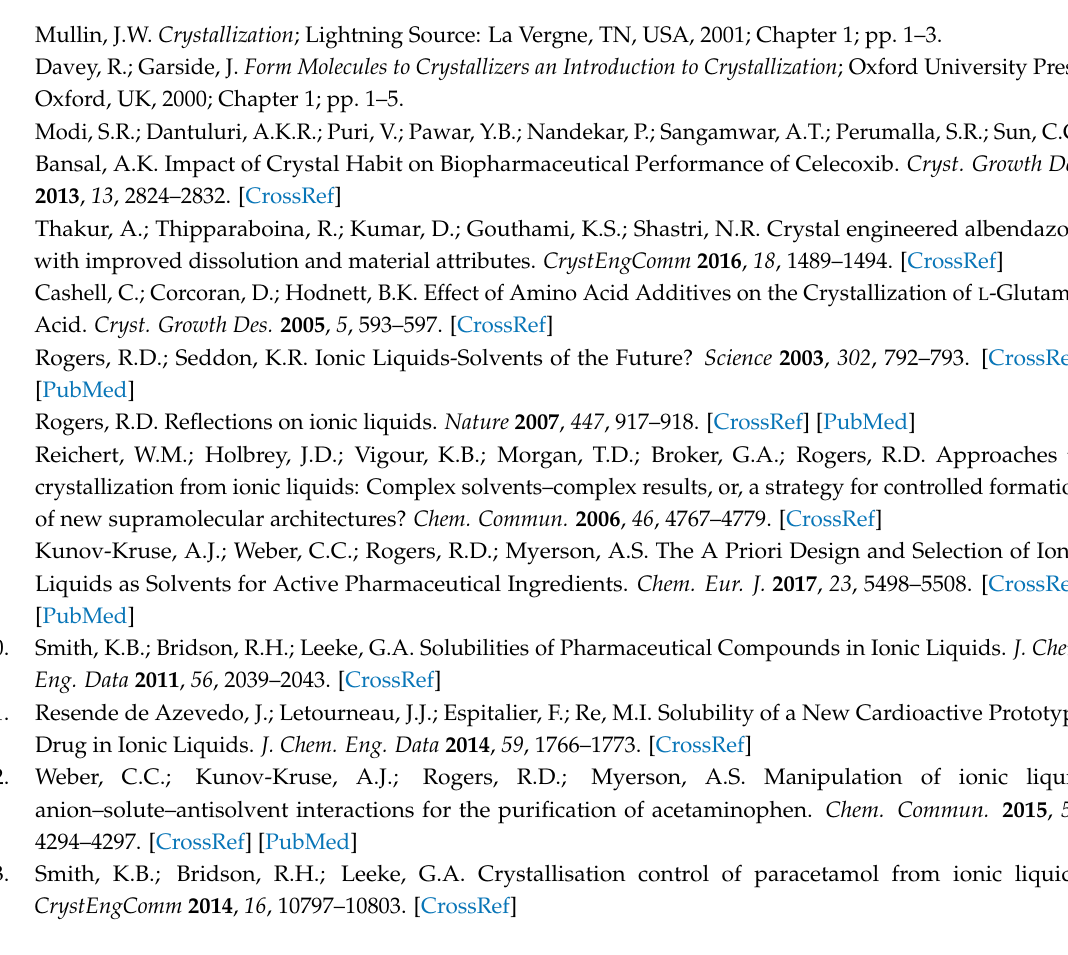
Figure S1. Crystal morphology of the currently commercialized sucrose crystals recorded by using the video microscope; Figure S2. PXRD patterns of sucrose crystals isolated from the MeOH extraction solution of A. gigas under controlled solvent volume (3 mL) and BMImBF 4 anti-solvent concentration change conditions, using crystallization techniques; Figure S3. PXRD patterns of sucrose crystals produced from the MeOH extraction solution of A. gigas at constant solvent volume of 3 mL under BMImPF 6 anti-solvent composition variation conditions using the crystallization method; Figure S4. Video-microscope photographs of sucrose crystals obtained from the MeOH extraction solution of A. gigas (solvent volume of 3 mL) using, respectively, BMImBF 4 , AEImBF 4 , and AAImBF 4 as anti-solvents ( A. gigas extraction solution /ILs (1:1 v / v )); Figure S5. DSC curves (heating rate: 10 ◦ C/min) of sucrose crystals produced from the MeOH extraction solution of A. gigas at a constant solvent volume of 3 mL under BMImTFSI anti-solvent composition variation conditions using the crystallization method; Figure S6. 19 F-NMR spectrum of BMImPF 6 (solvent: D 2 O); Figure S7. 19 F-NMR spectrum of sucrose crystals precipitated from BMImPF 6 . ( A. gigas extraction solution/ILs: 3 mL/3 mL (1:1 v / v ), solvent: D 2